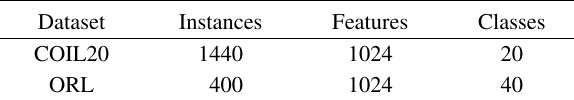
Table 1 Two image datasets used for performance